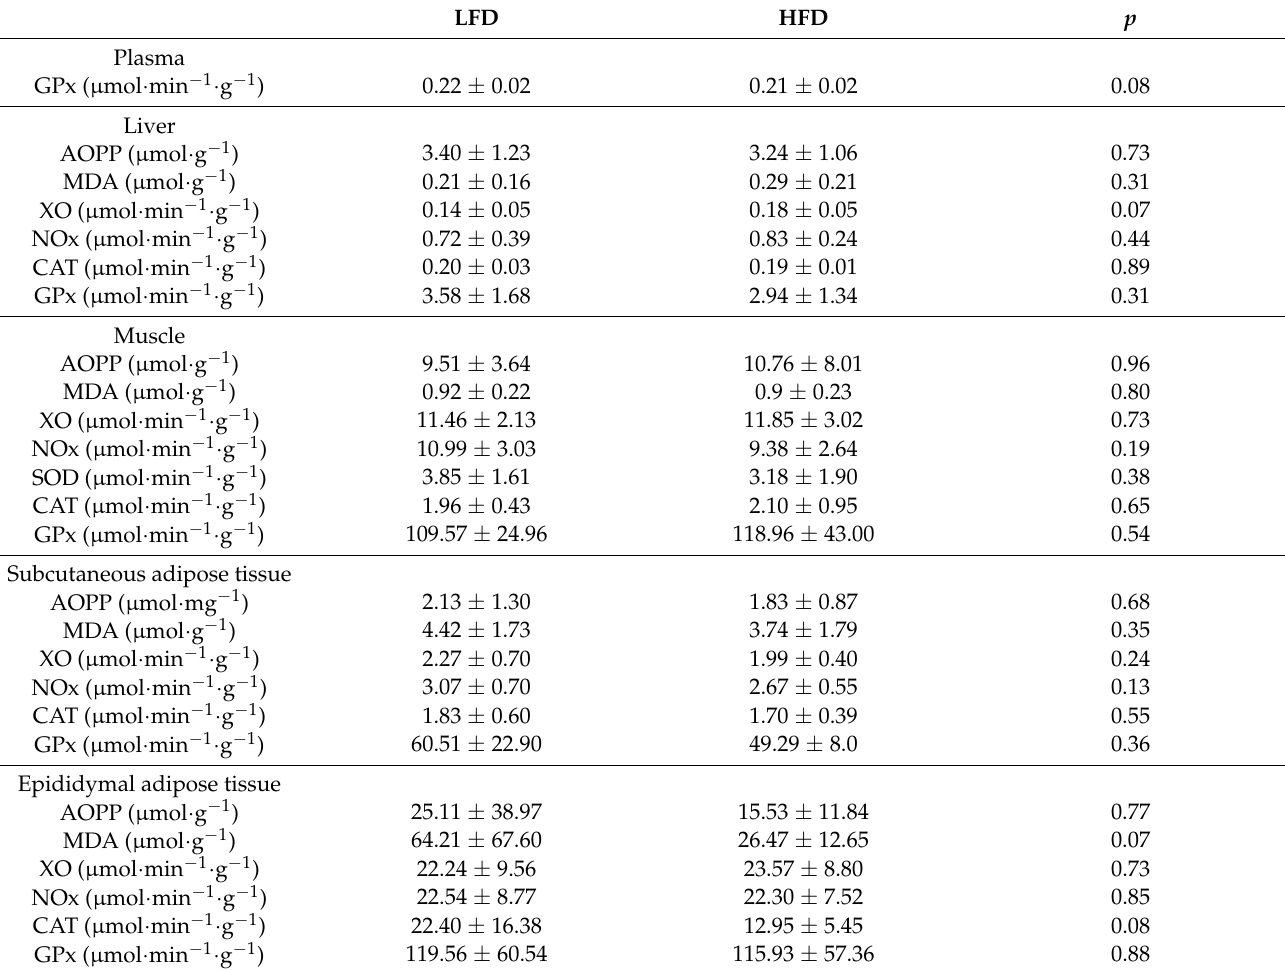
Table 1. Pro/antioxidant markers in the LFD ( n = 12) and HFD ( n = 12) groups at the end of phase 2 (training and/or LO supplementation for 12